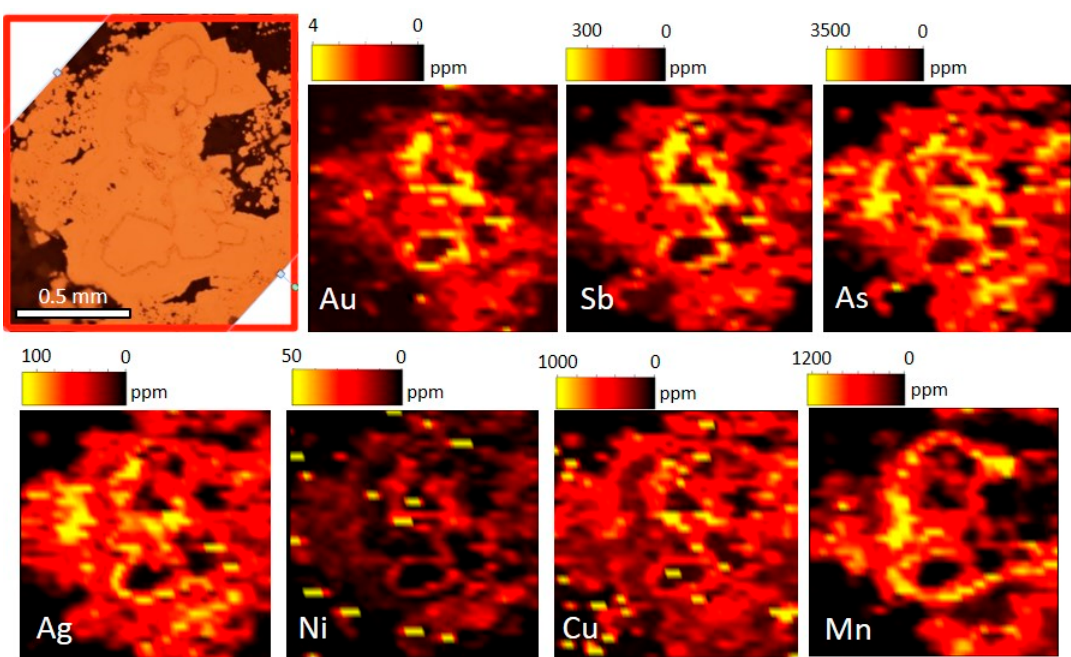
Figure A1. Au, Ag, As, Sb, Ni, Cu and Mn distribution maps of the colloform banded pyrite (Py III) aggregate 2 from sample Cast-004. The maps show semi-quantitative values.